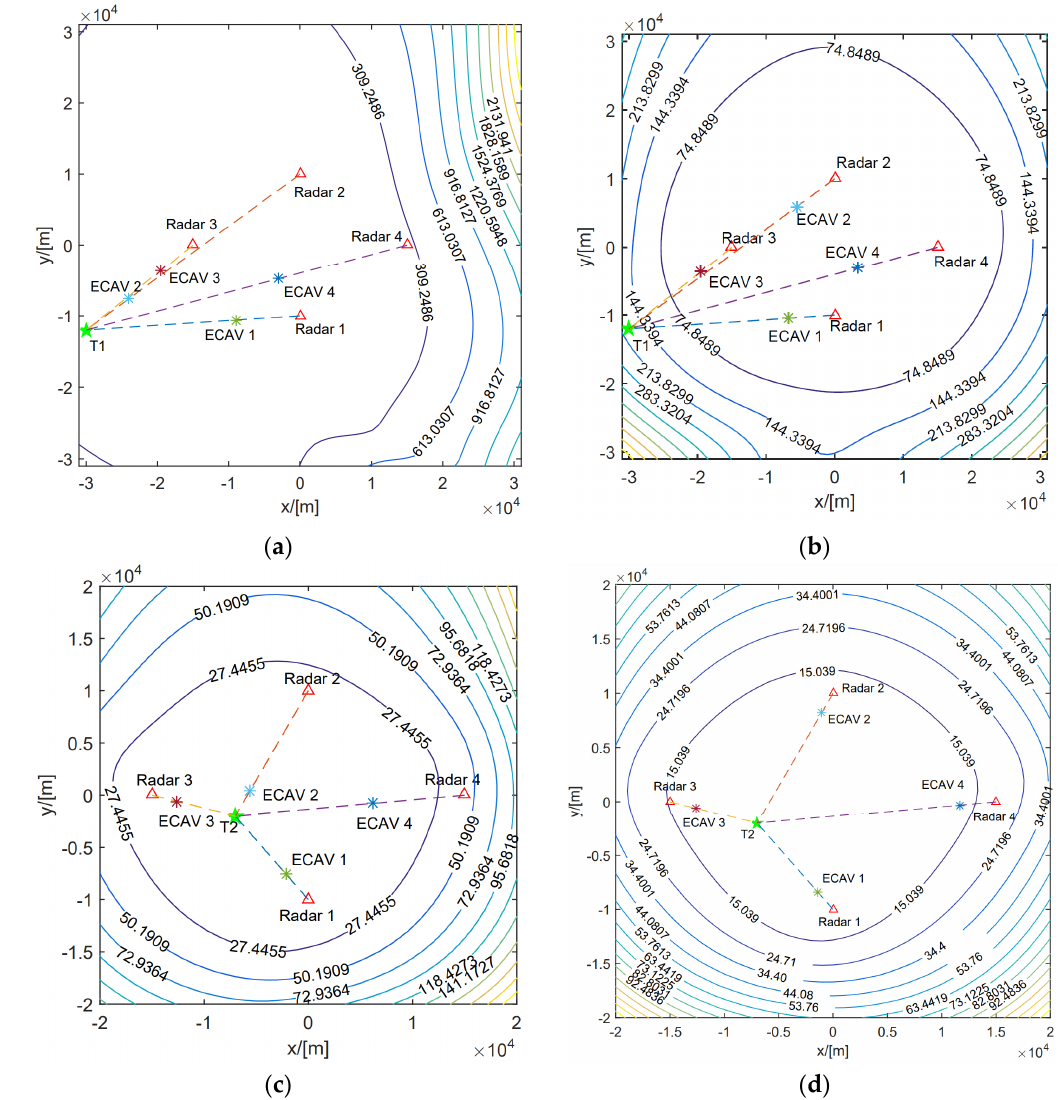
Figure 6. The localization accuracy of different phantom track points. ( a ) Phantom target point is far from radars. ( b ) Using FIM to optimize UAV deplyment in ( a ). ( c ) Phantom target point is close to radars. ( d ) Using FIM to optimize UAV deplyment in ( c ).